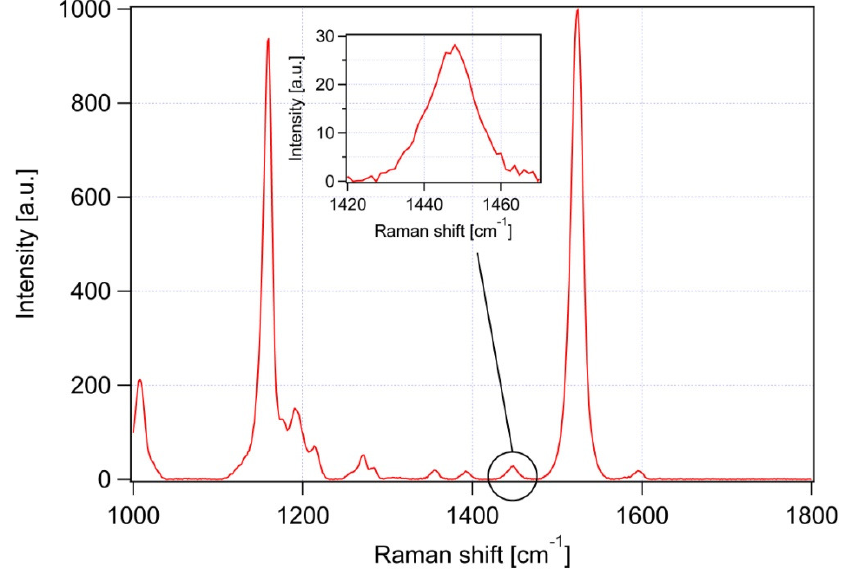
Figure 7 . Raman scattering spectrum of β -carotene. The inset shows the detail of β -carotene band at 1,442 cm −1